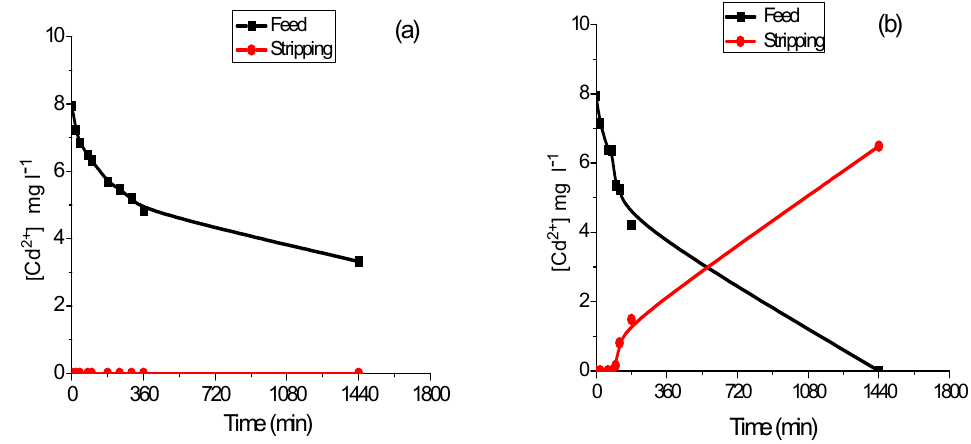
Figure 2. Transient concentration curves in Cd (II) transport experiments involving PIM 1 ( a ) and PIM 2 ( b ).